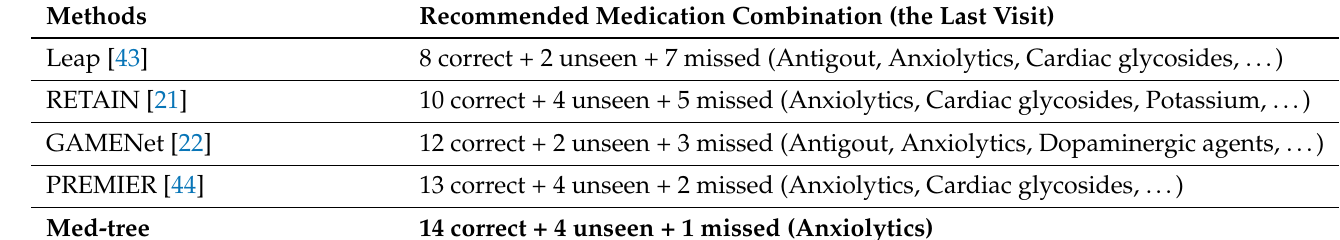
Table 6. Results of the last recommended medications for a patient with a total of five visits on MIMIC- III datasets. Here, “unseen” indicates the drugs are not appearing in the actual recommendation results, while “missed” refers to the drugs that should be recommended in the actual situation but are not